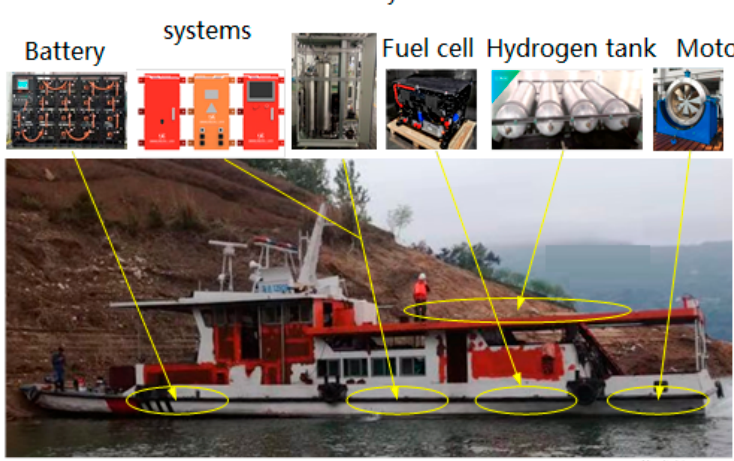
Figure 3. Fuel cell powered ship of the pilot project in China.